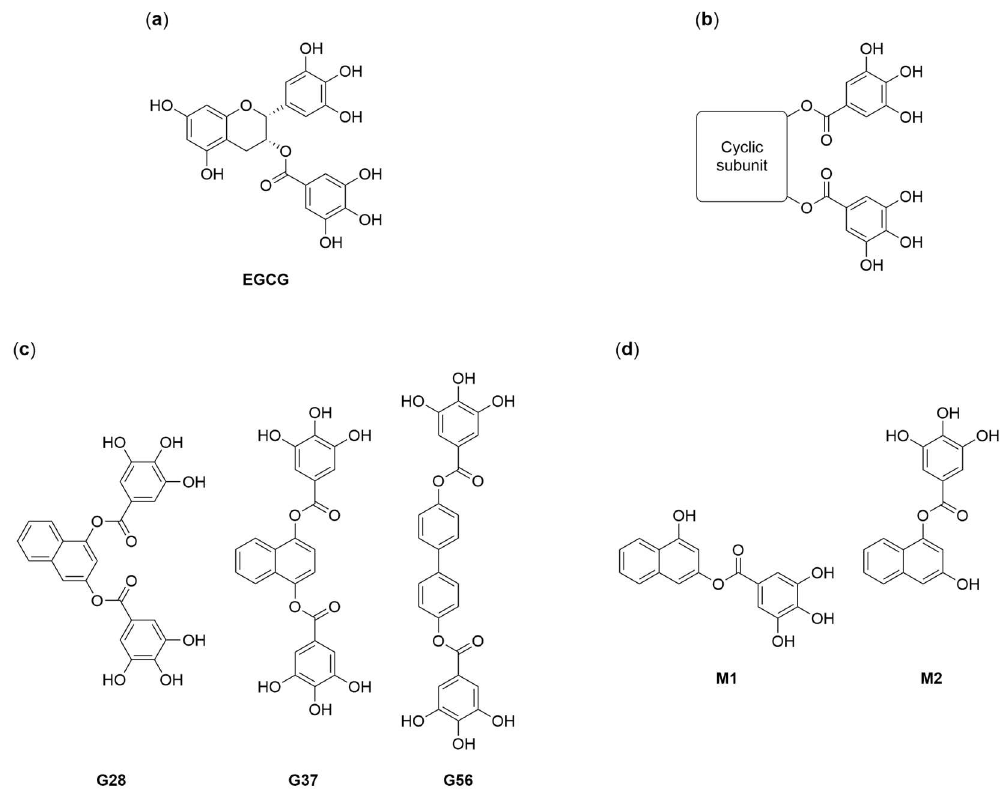
Figure 1. Structures of (−)-epigallocatechin 3-gallate (EGCG) ( a ), EGCG derivatives ( b ), the lead diesters ( c ) and the monoesters of G28 ( d ) [21,22,26].